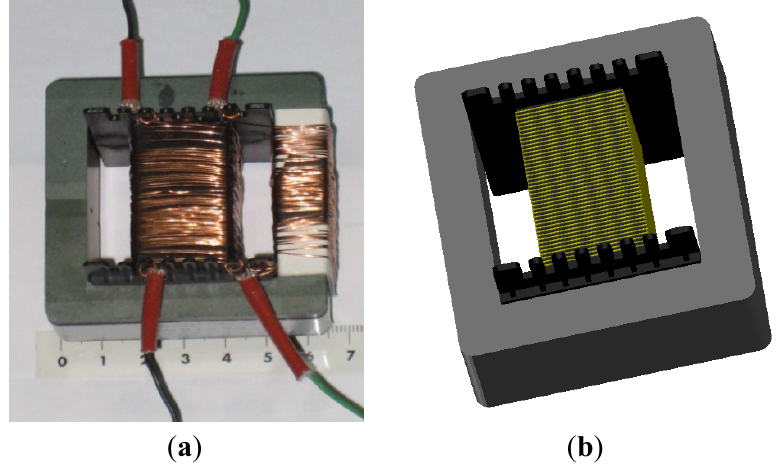
Figure 5. ( a ) Real transformer with E65/32/27 core and two windings of 45 turns; ( b ) E65/32/27 geometry used in the 3D